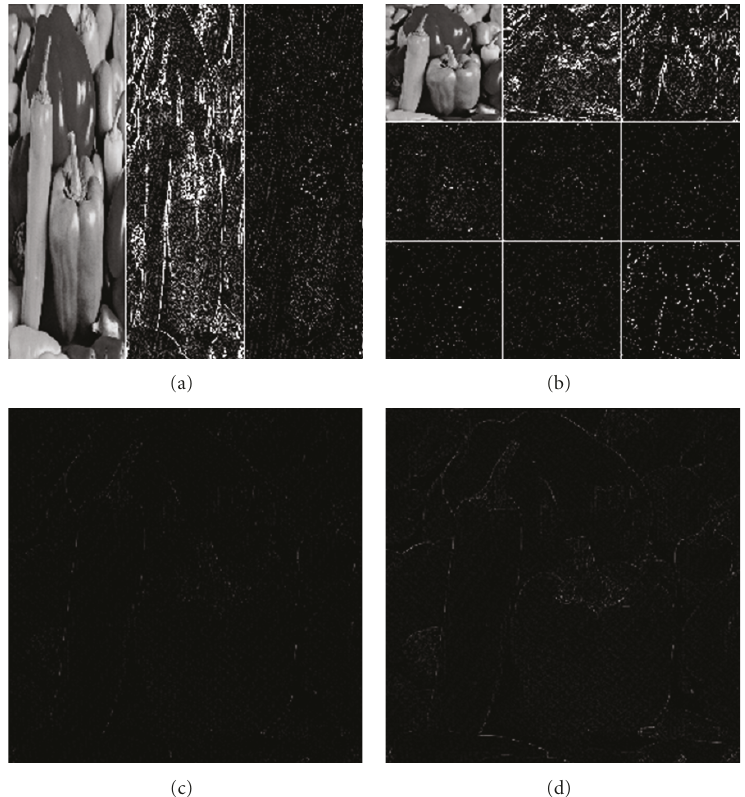
Figure 7: One- and two-dimensional FMP representation: (a) and (c) one-dimensional FMP component and error images, respectively, (b) and (d) two-dimensional FMP components and error image,